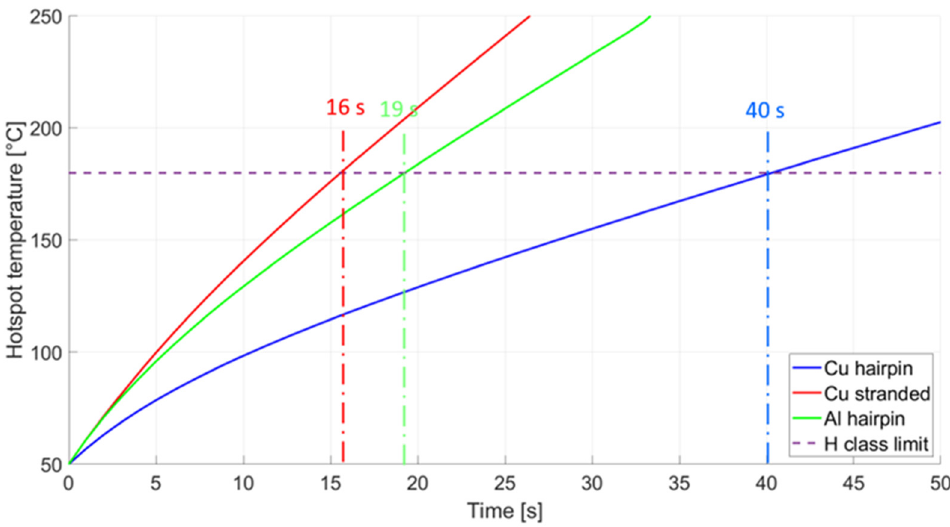
Figure 5. Hotspot temperatures in the thermal transient area at maximum power for the three proposed designs.